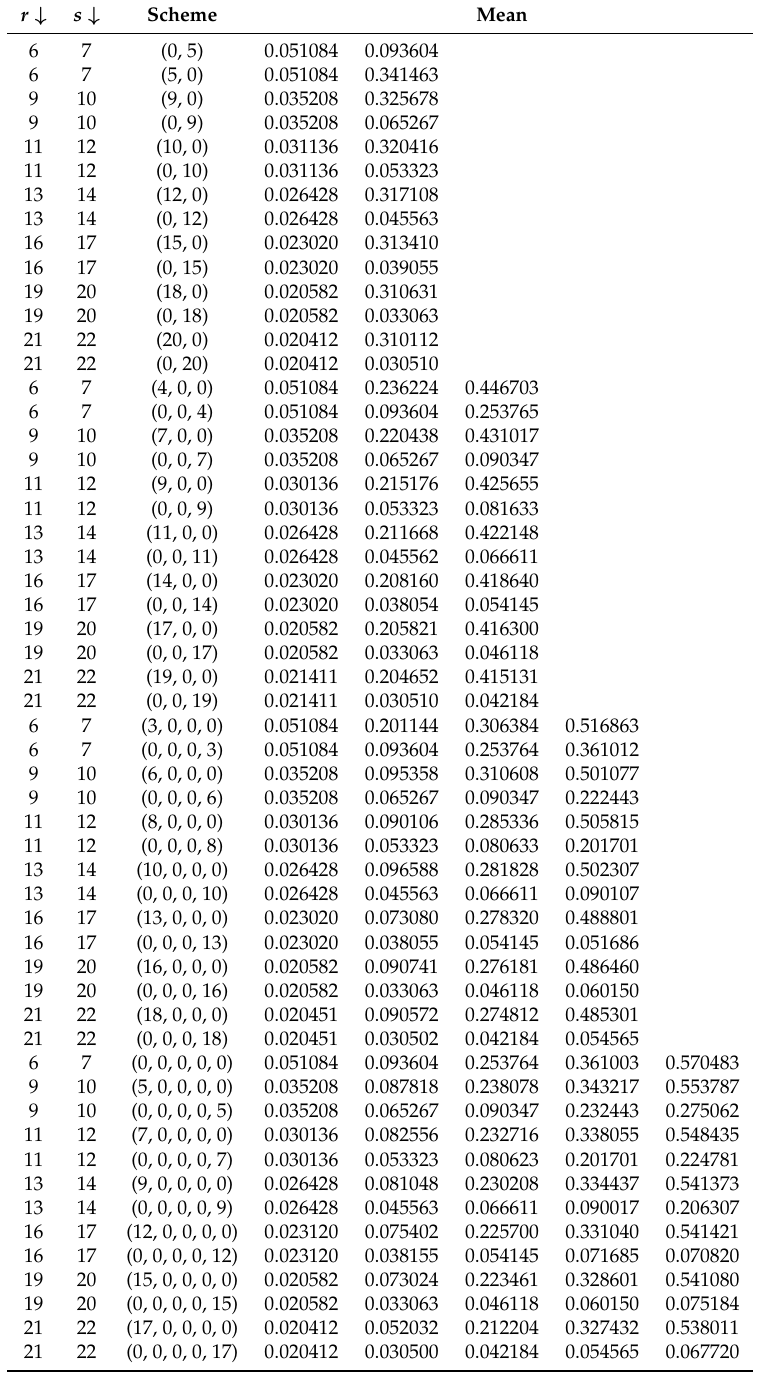
Table 2. Means of two parameter RK distribution for different values of parameters, e.g., µ = 3 and λ =